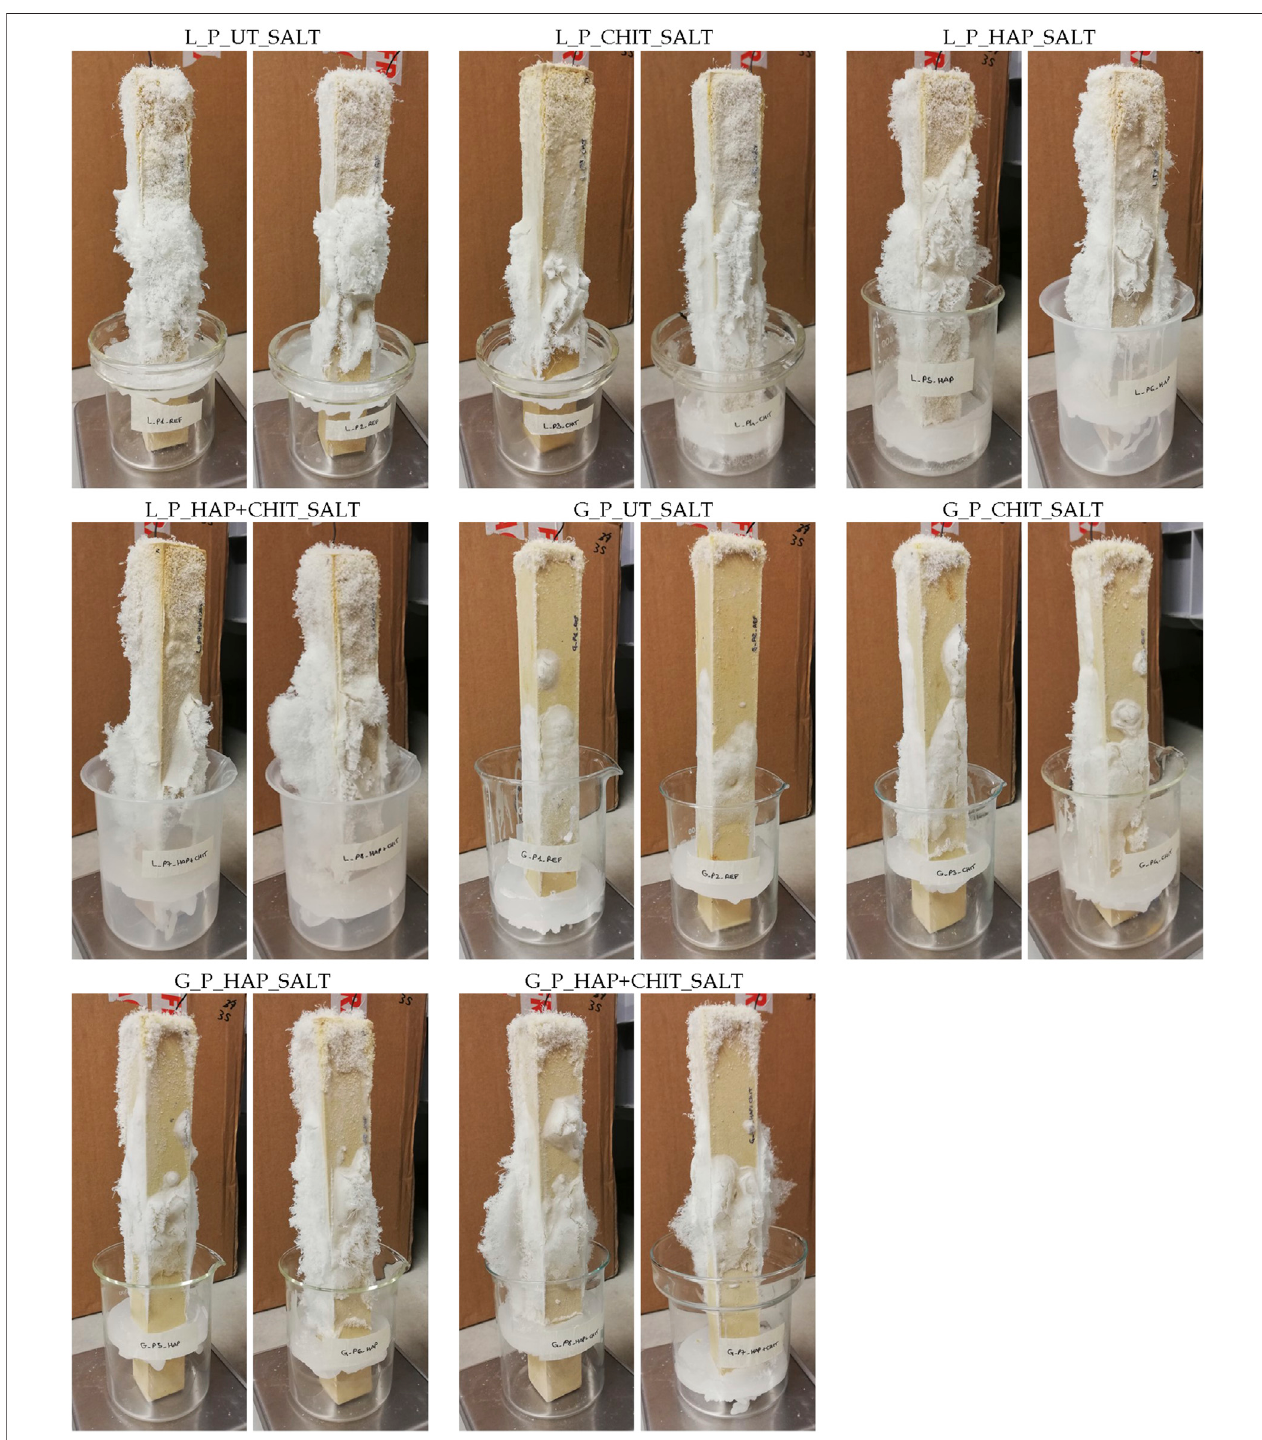
FIGURE 9 | Prismatic samples at the end of the fi rst continuous absorption test, before brushing.